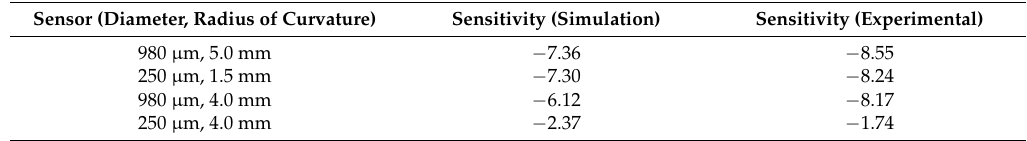
Table 2. Comparison of simulated and experimental sensitivities.